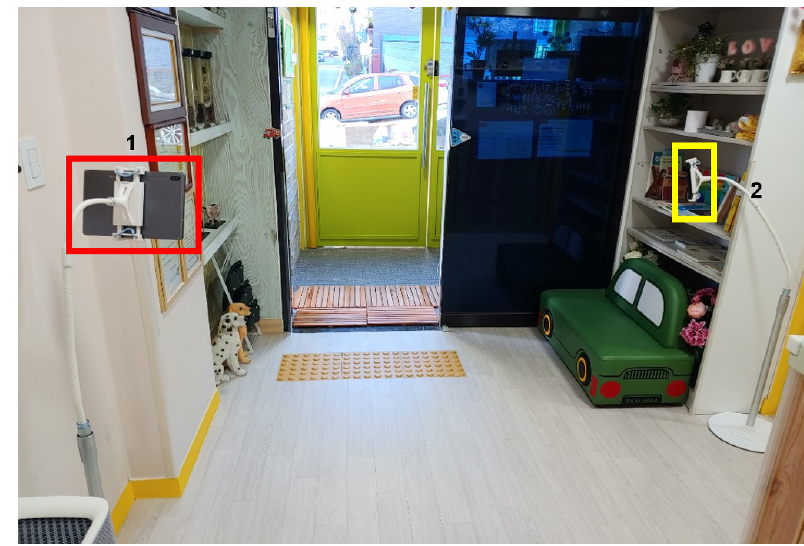
Figure 12. Installation of the camera indoors